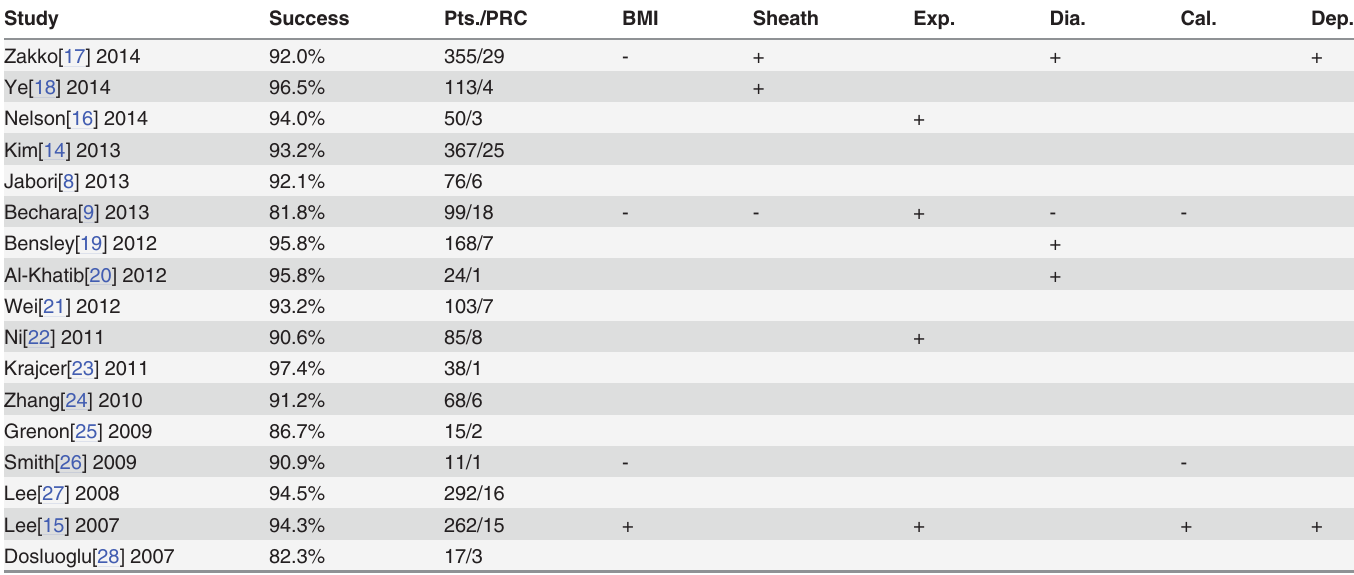
Table 5. PRC and factors referred in recent studies of Perclose Proglide in